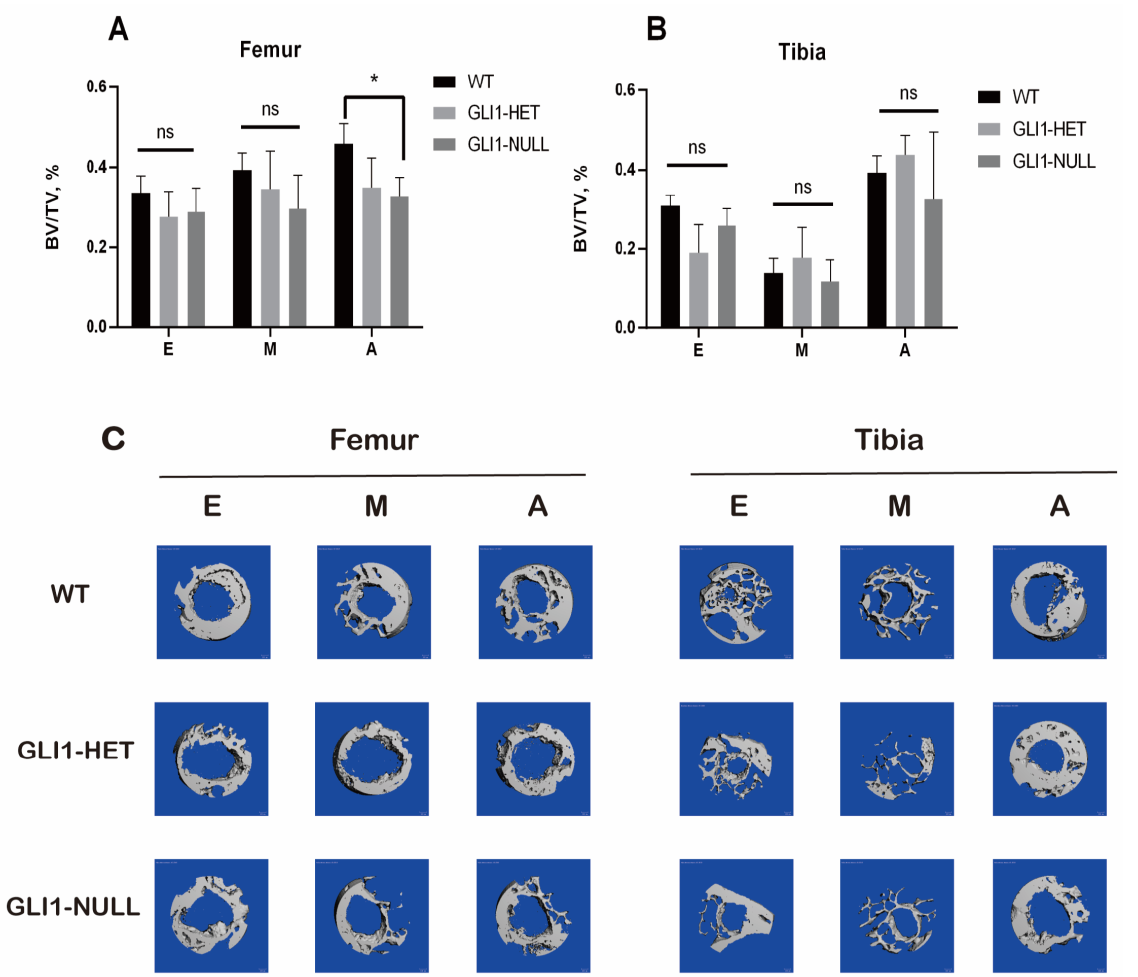
Figure 10. Results of micro-CT analyses for wild-type, GLI1-HET, and GLI1-NULL mice at 4 weeks after ACLR (40×). ( A , B ) Bone volume/total volume (BV/TV) in all three groups. Values are presented as mean ± SD. *, p < 0.05. ( C ) 3D-reconstruction images of all three groups (E: tunnel exit, M: mid-tunnel, A: aperture).